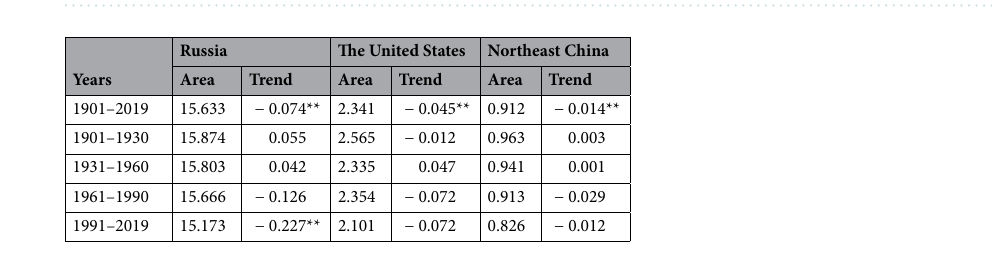
Figure 6. Spatial distribution and variation of the Qinghai-Tibetan Plateau cold regions from 1901 to 2019.